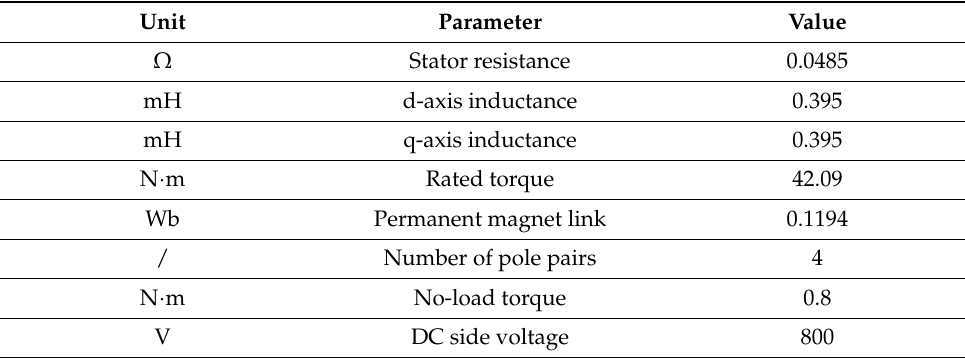
Table 1. The relevant parameters of